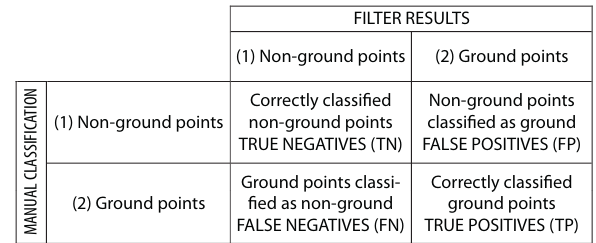
Table 1. Confusion matrix used to compare the manual classification and the classification from the filtering technique.